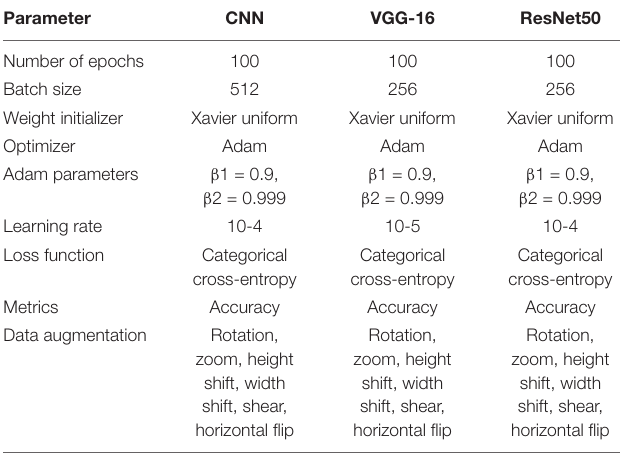
TABLE 2 | Hyperparameters of CNNs adopted in the experiments.